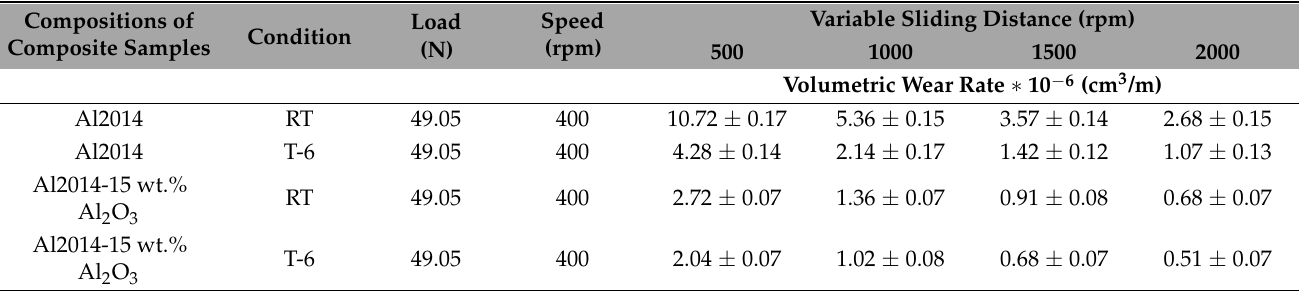
Table 6. The volumetric wear rate of before and after heat-treated Al2014 and Al2014-15 wt.% Al 2 O 3 composite with variable sliding distance at constant load and